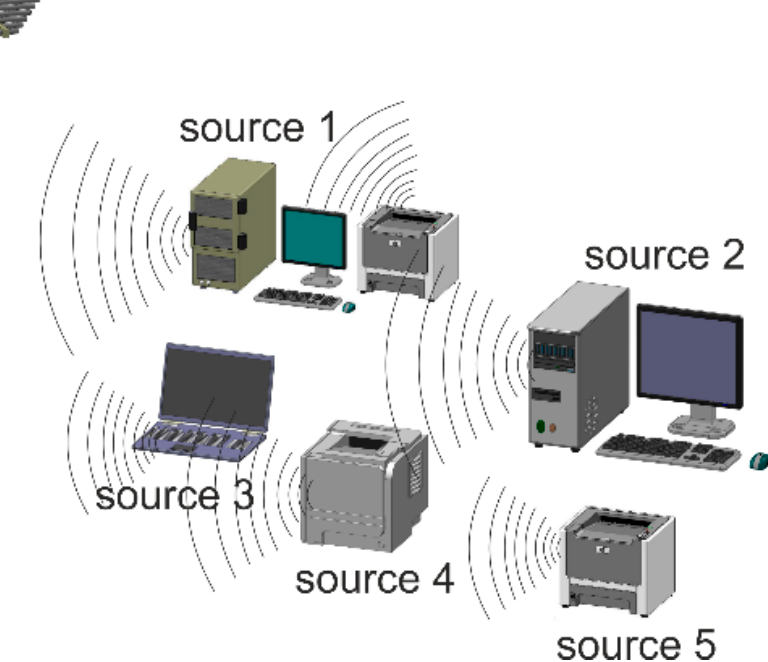
Figure 1. Surrounding us potential sources of undesirable emissions correlated with the information processed.